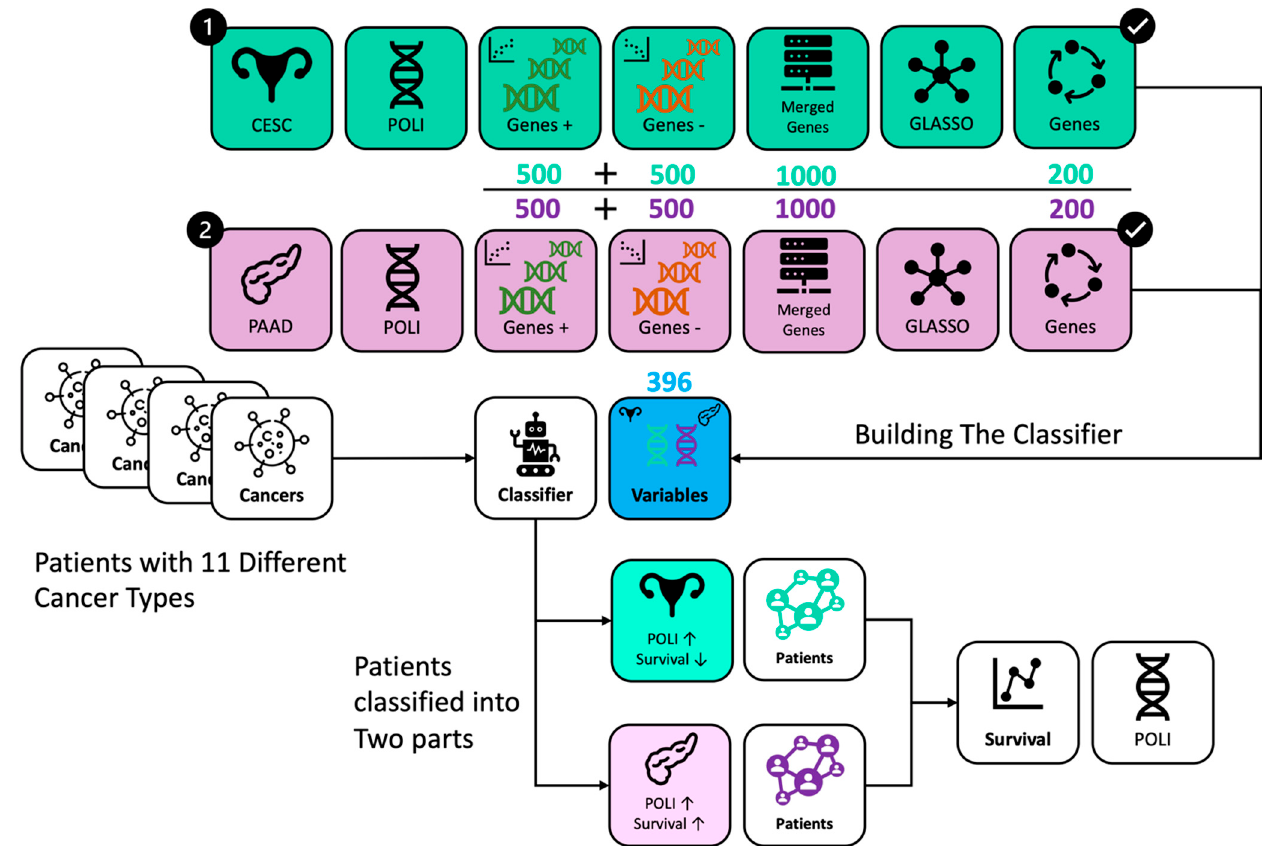
Figure 4. Workflow of data processing and analysis. Genes were selected from CESC in green and PAAD in purple, respectively. RFC incorporated 396 genes from CESC and PAAD. Patients with different cancer types were classified into two groups with the same POLI signature on survival as in CESC and PAAD.